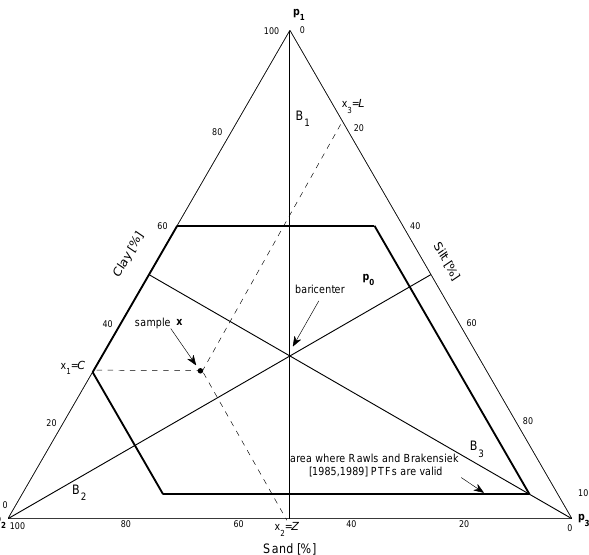
Fig. 1. Representation of a sample x =( C,Z,L ) in the texture triangle with indication of the bisectors B 1 , B 2 and B 3 , the vertices p 1 , p 2 , p 3 and the boundary conditions on the PTFs of Rawls and Brakensiek (1985, 1989).